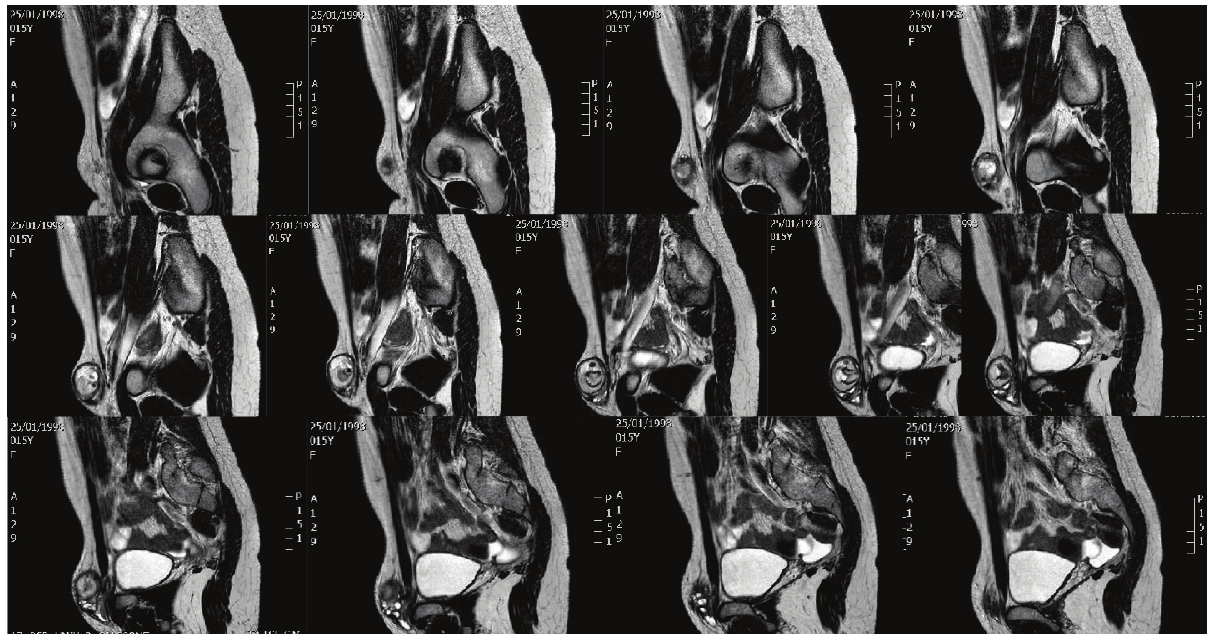
Figure 3: MRI study revealing the ovarian mass herniated in the inguinal region, sagittal section.